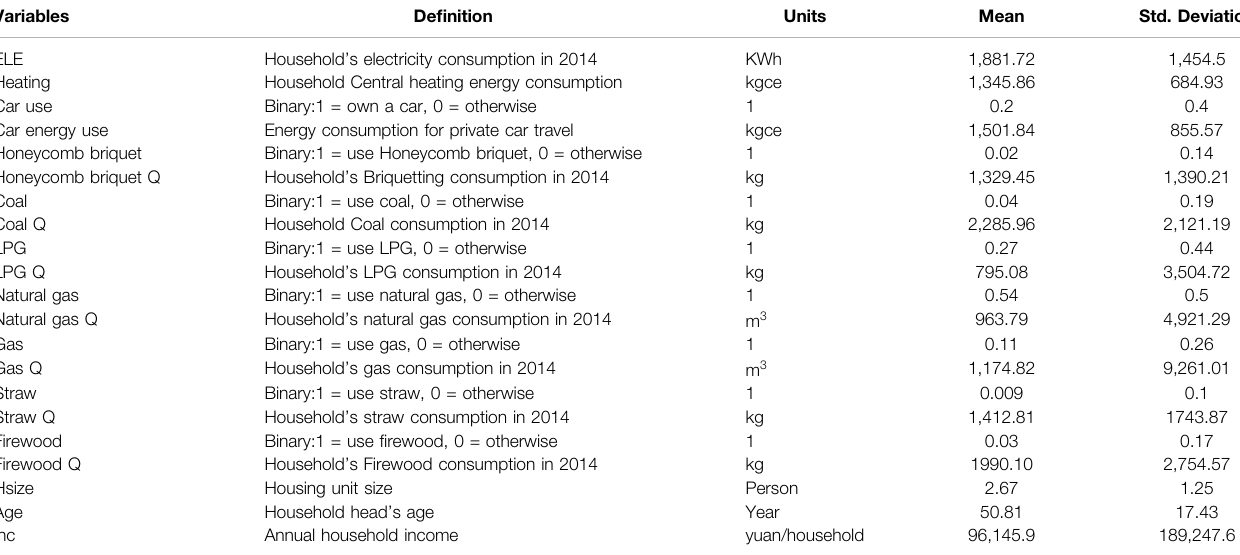
TABLE 1 | De fi nitions and descriptive statistics of household-level variables. Variables